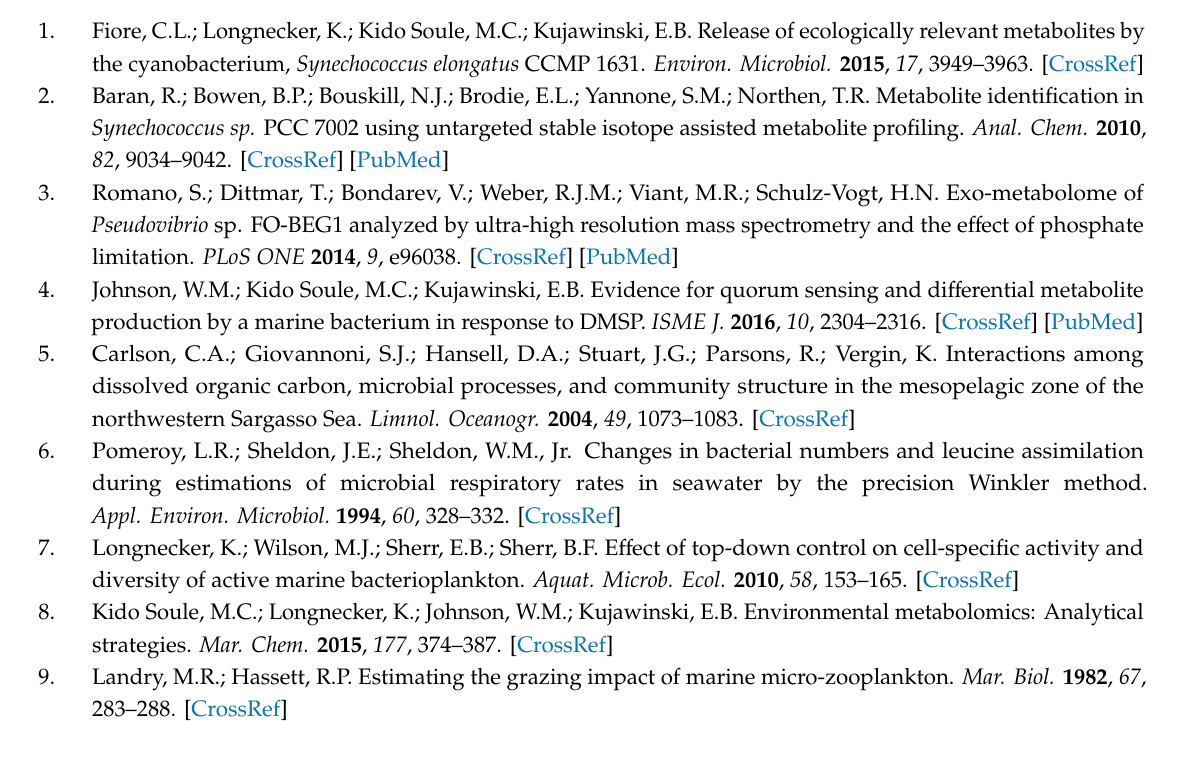
Figure S1: Nucleic acid precursors, Figure S2: Changes in amino acid concentrations, Figure S3: Average peak areas for each color module, and Figure S4: Heatmap with correlations between the targeted and untargeted metabolomics